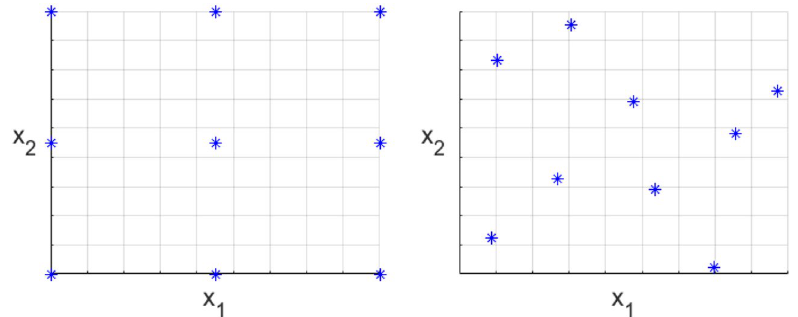
Fig. 2 Examples for full- factorial design (left) and Latin hypercube sampling